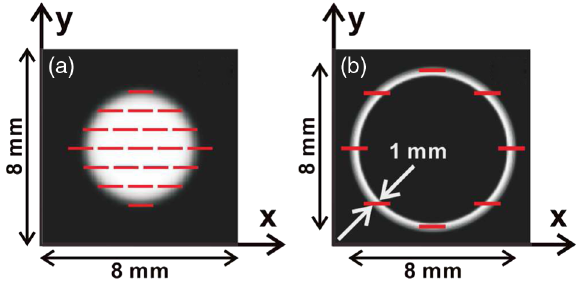
FIG. 10. Calculated laser intensity j E ð t Þj 2 distributions of probe laser before (a) and after (b) hollow shaping on the xy plane and polarization directions (fields oscillation direction) are overlaid with red lines.